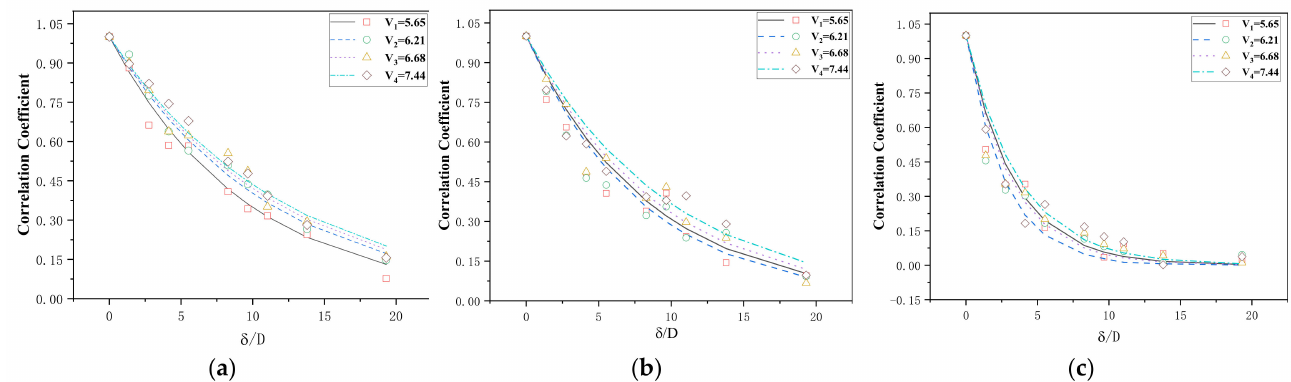
Figure 7. Spanwise correlation of aerodynamic coefficients in static state ( δ /D: dimensionless spacing). ( a ) Spanwise correlation of lift coefficient; ( b ) Spanwise correlation of torque coefficient; ( c ) Spanwise correlation of resistance coefficient.